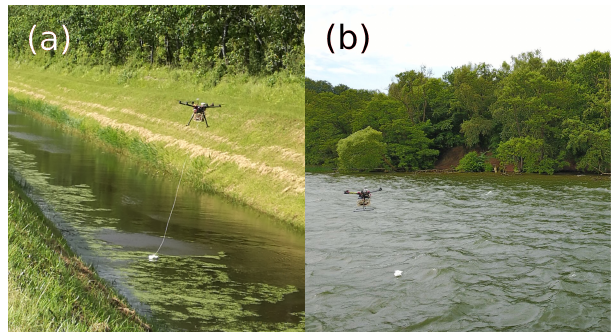
Figure 1. Pictures of the UAV and the tethered sonar. These pictures were retrieved in (a) Marrebæk Kanal, Denmark; and (b) Furesø lake, Sjælland, Denmark. In (b) the drone was flown a few hundred meters from the shore and the picture was retrieved using an optical camera onboard an auxiliary UAV (DJI Mavic